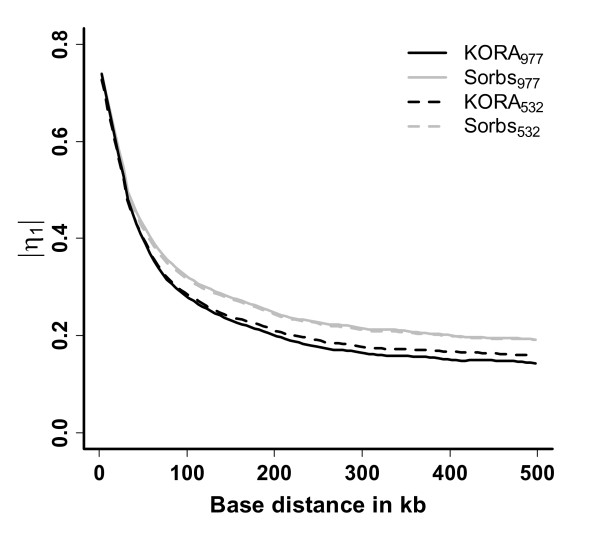
LD structure in KORA and Sorbs. LD structure in the KORA977, KORA532, Sorbs977 and Sorbs532 samples. η1 was estimated for all SNP pairs of chromosome 22. Results are averaged over distance using bins of 5 kb length and smoothed by a LOWESS estimator.